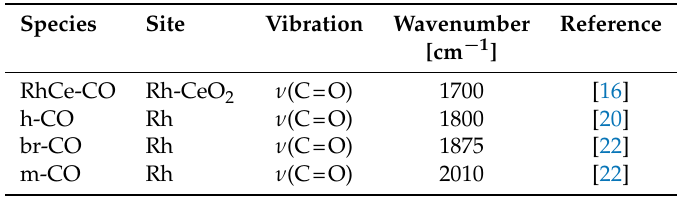
Table 1. Infrared peak assignments for the transient experiments in the 2100–1700 cm − 1 region. The wavenumber values are approximated ( ± 10 cm − 1 ) due to fluctuations during the time series and between the different